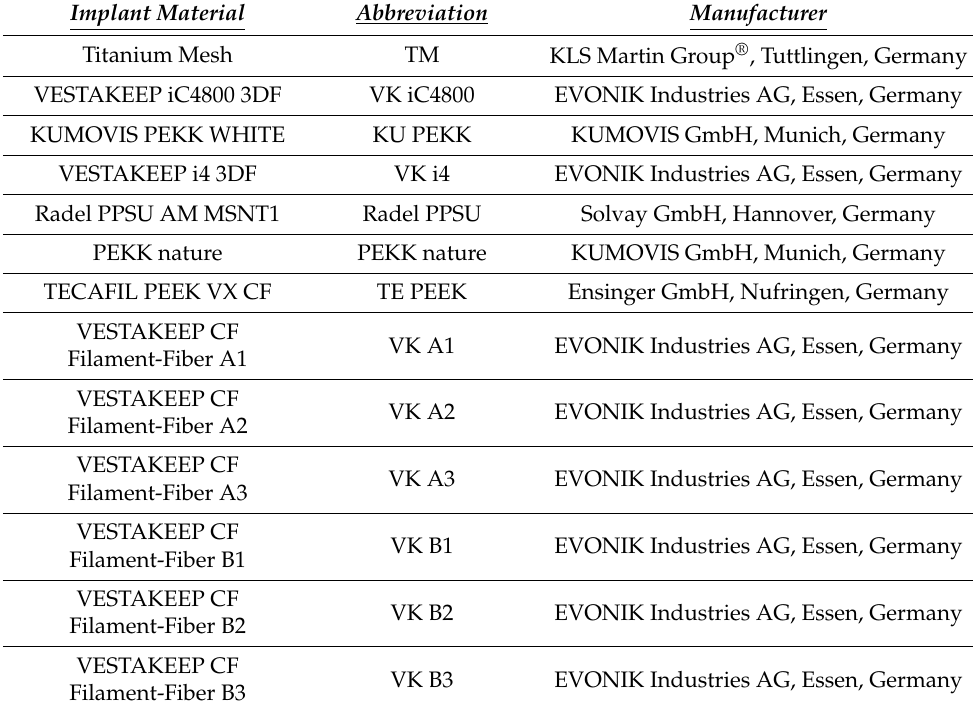
Table 1. List of all implant material names, abbreviations and